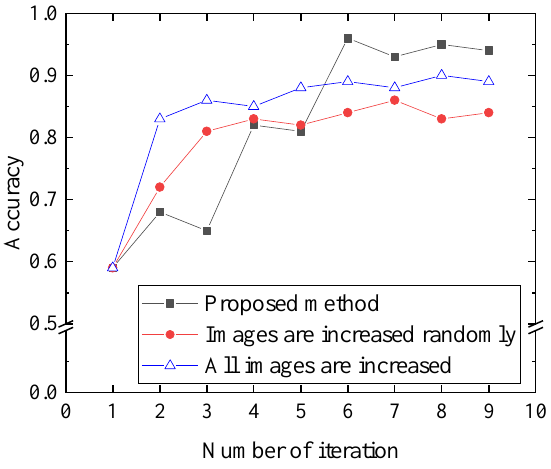
Figure 8. Comparison of accuracy between the proposed and conventional methods.